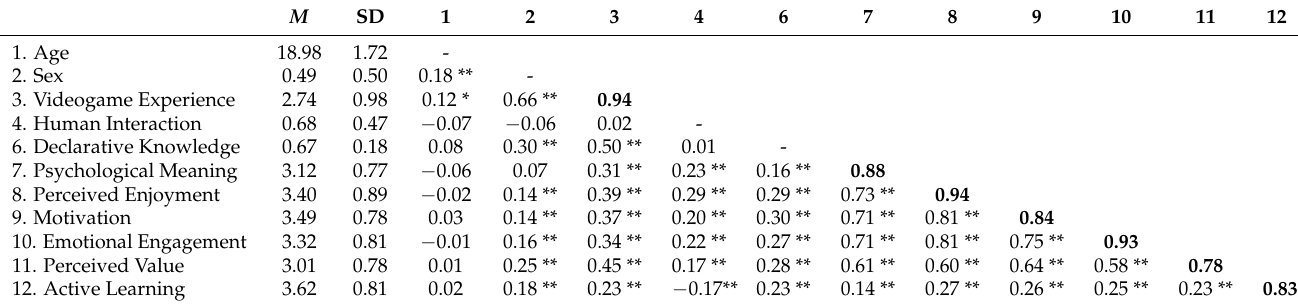
Table 1. Means, standard deviations, and correlations for observed study